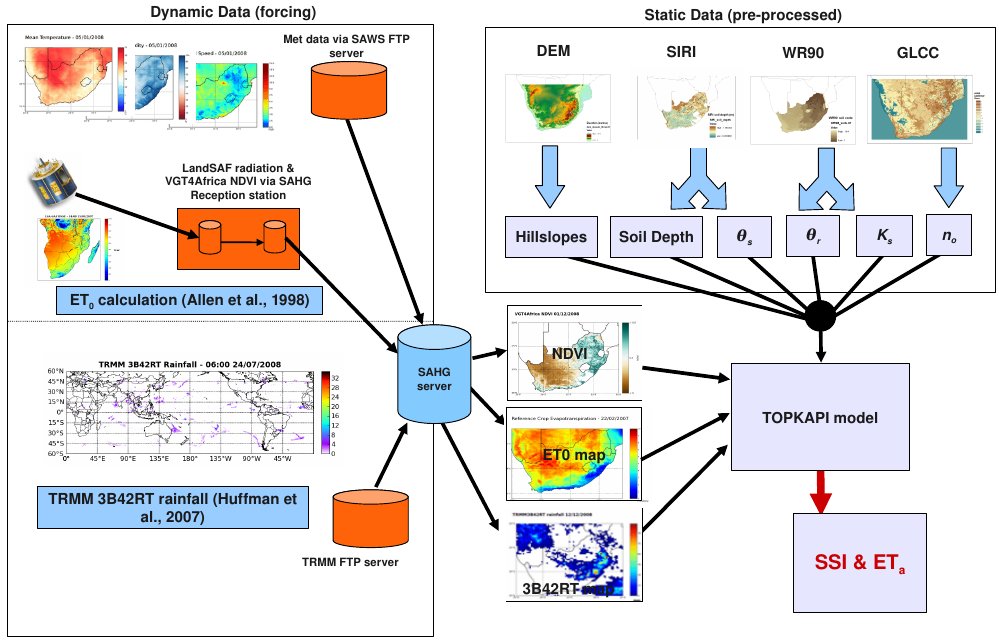
Fig. 8. A flow chart, showing the sources of data used to compute SSI with the TOPKAPI model. The dynamic forcing data comprises rainfall (bottom left panel) and the data required to compute ET 0 (top left panel). The static data are used to derive local slope (DEM) and soil properties. The overland roughness n o and soil condictivity K s control the flow of water in the cell, while the the residual and saturated soil moisture contents ( θ r ,θ s ) are combined with the soil depth to compute available water storage capacity.